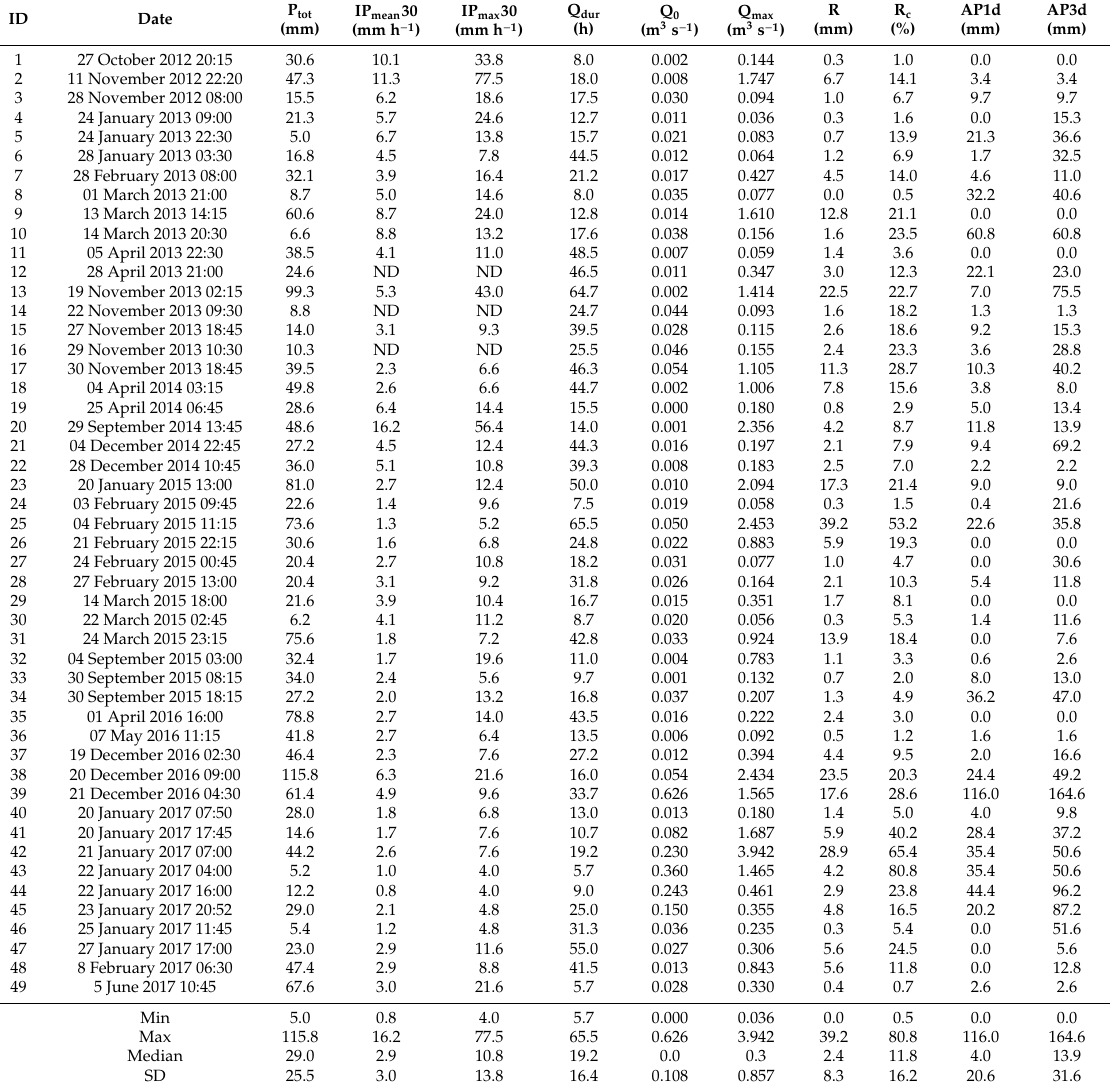
Table A3. Flood event characteristics during the study period 2012–2017 in the Es Fangar